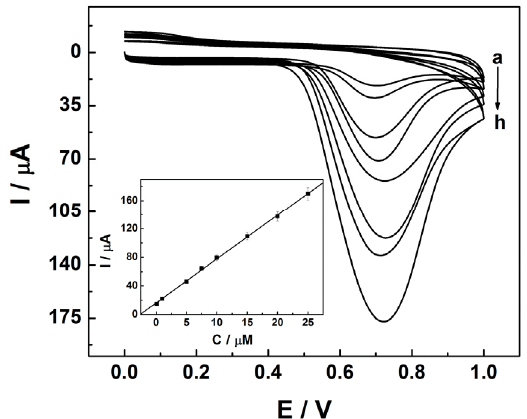
Figure 3. Cyclic voltammograms at the CTAB/CP electrode in PBS (pH 7.0) containing (a–h): 0.1, 1, 5, 7.5, 10, 15, 20, 25 μ M NP. The inset is a plot of the linear relationship between the oxidation peak current and the concentration of